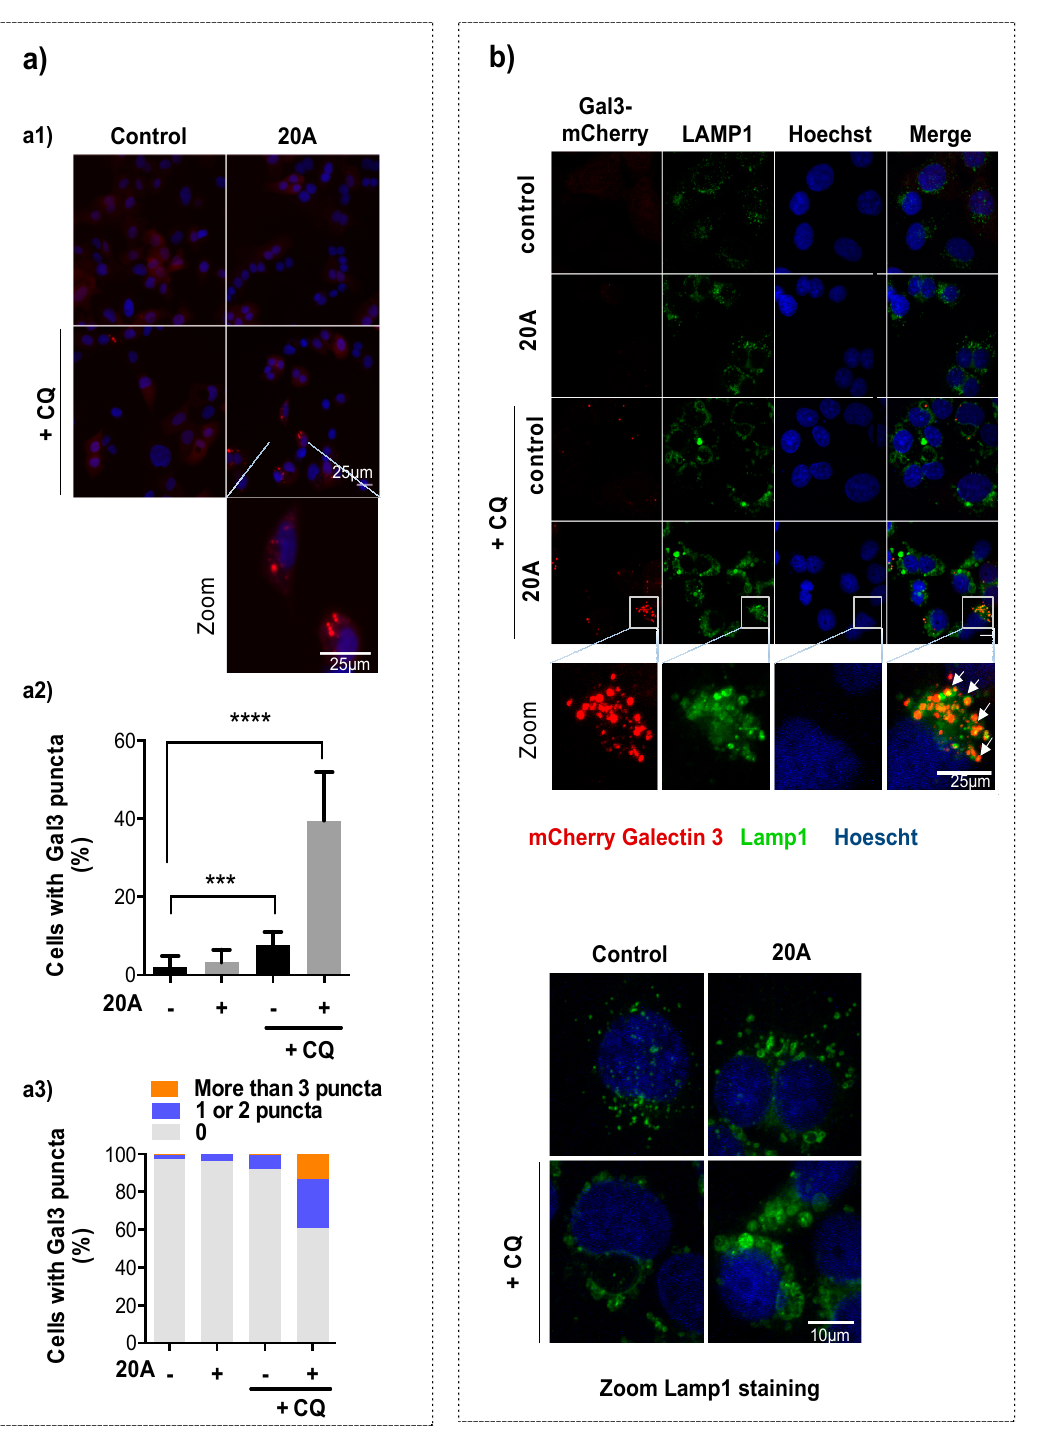
Figure 4. 20A and chloroquine act in concert to trigger LMP in cancer cells. ( a ) mCherry-Galectin3 expressing U2OS cells were treated or not with 3 µ M 20A in either the presence or absence of 25 µ M chloroquine for 24 h. ( a1 ) representative fluorescence images of Galectin 3 staining (red signal) and nuclei stained with Hoechst (blue signal) are shown; scale bar represents a distance of 25 µ m. ( a2 ) The percentage of cells displaying at least one Galectin 3 punctae is scored. Data are presented as mean